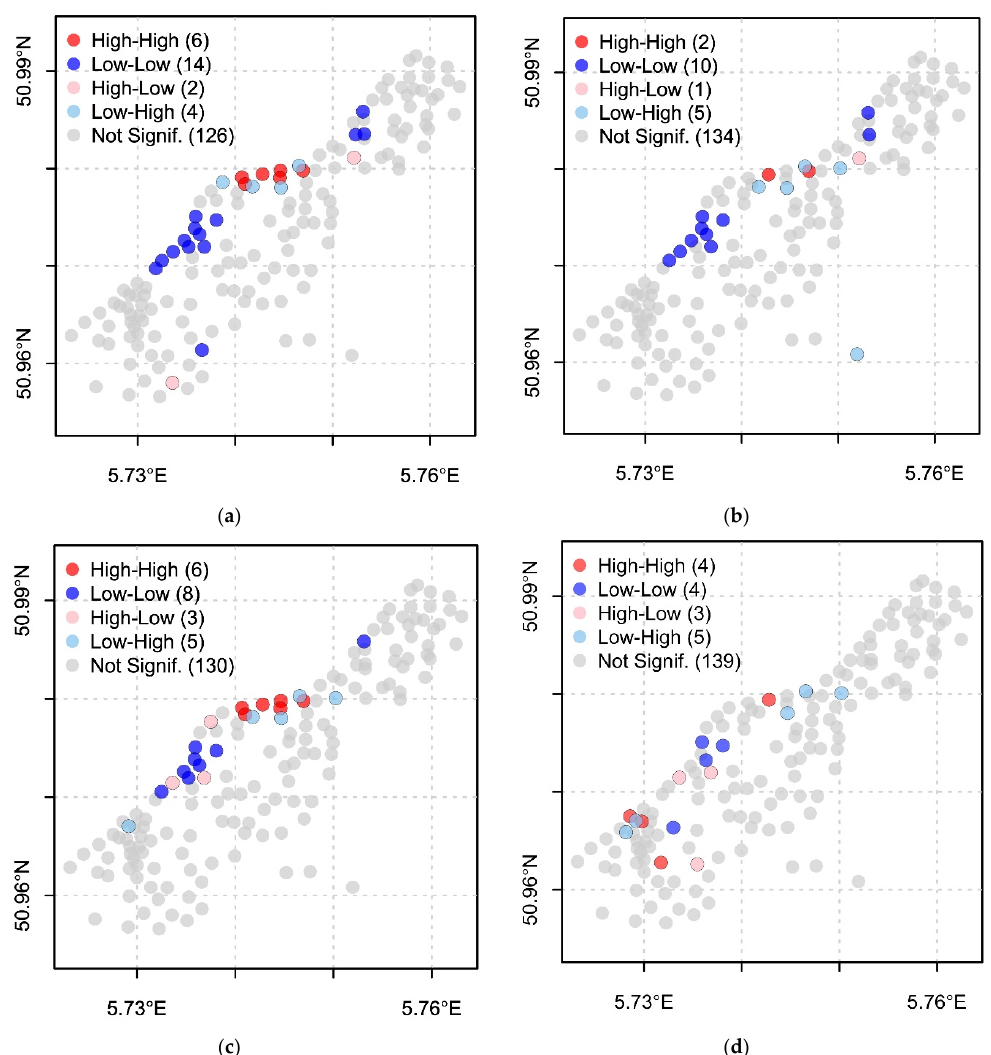
Figure 4. LISA clusters for the Meuse data: ( a ) Non-spatial model, ( b ) Spatial Lag model, ( c ) ESF model, and ( d ) GWR model. The significance level of LISA clustering is set to 5%.